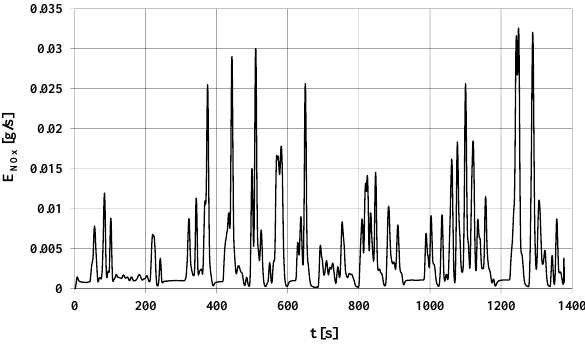
Fig. 9. The process of nitrogen oxides emission intensity in the Malta test